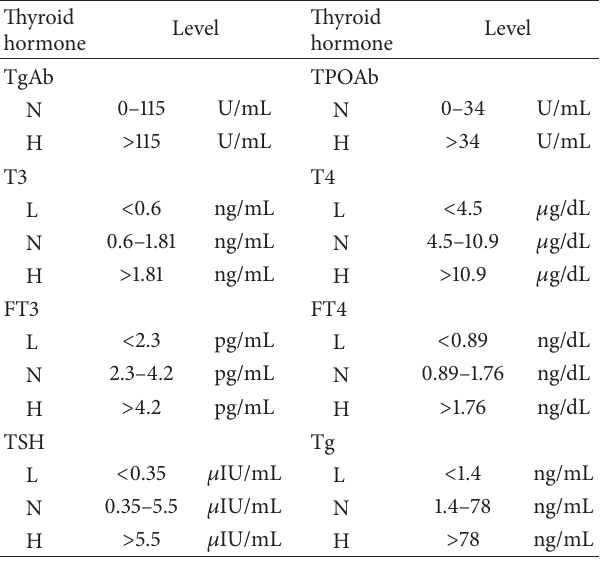
Table 1: The evaluation standards of the tests of thyroid functions.